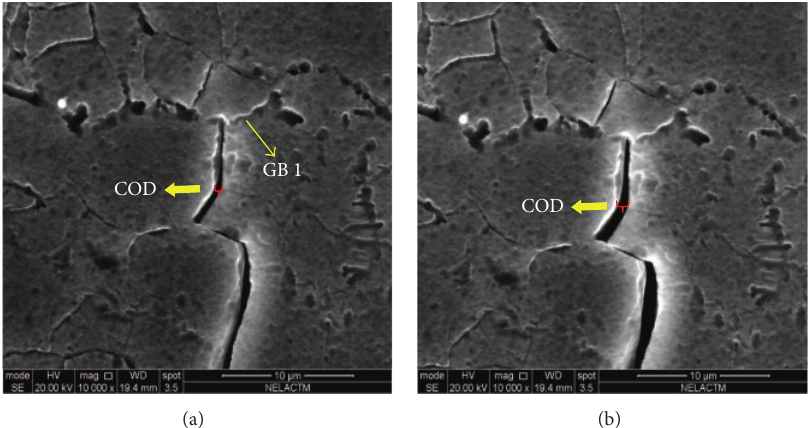
Figure 4: Micromorphology of fatigue crack: (a) at 77 cycles and (b) at 99